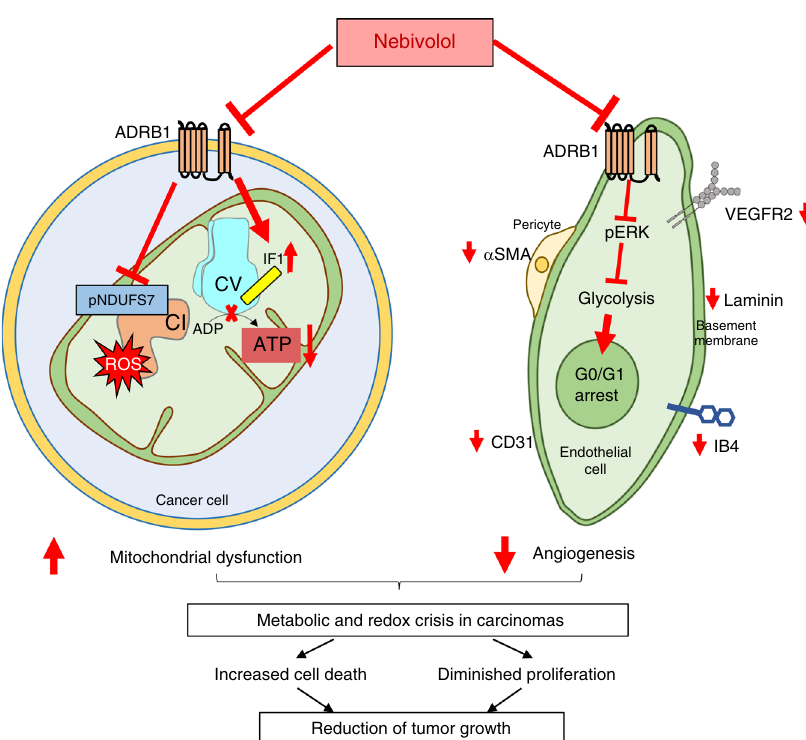
Fig. 9 Nebivolol induces a metabolic and redox crisis in carcinomas. The schematic summarizes the main events triggered by nebivolol to prevent the growth of colon and breast carcinomas. Nebivolol inhibits β 1-adrenergic signaling in cancer cells, preventing the phosphorylation of NDUFS7 (pNDUFS7, blue rectangle in CI) that limits the activity of Complex I (CI in orange) and mitochondrial respiration, favoring the generation of ROS (red star). Concurrently, nebivolol increases the mitochondrial content of the ATPase Inhibitory Factor 1 (IF1, yellow cylinder) that binds the ATP synthase (CV in light blue) and limits ATP production in the carcinomas. Moreover, nebivolol leads to diminished tumor angiogenesis by inhibiting proliferation in endothelial cells through β 1-adrenergic-mediated glycolysis inhibition and thus, cell cycle arrest. These events result in a metabolic (less ATP) and redox crisis (increased ROS) that limit cellular proliferation and enhanced death of cancer cells preventing the in vivo growth of the the FDA-approved β -blocker restrains the growth of colon and breast carcinomas. In addition, the side effects of nebivolol in hypertensive patients are tolerated. Overall, incorporating nebi- volol as an additional cancer drug tackles simultaneously tumor angiogenesis and restrains mitochondrial functions, resulting in an overall metabolic and oxidative stress condition that halts tumor growth.